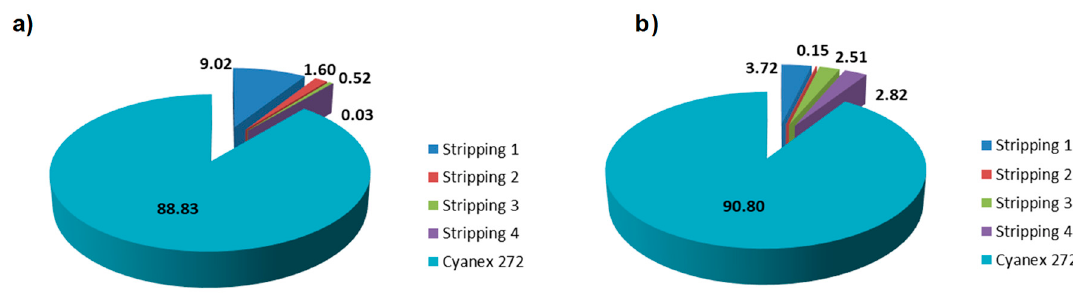
Figure 11. Cyanex 272 losses during the adsorption–desorption cycles and the remaining on the nanofiber surface for ( a ) Eu(III) and ( b ) Y(III).